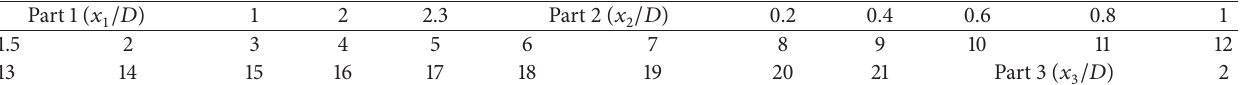
Table 1: Rocket segmentation.